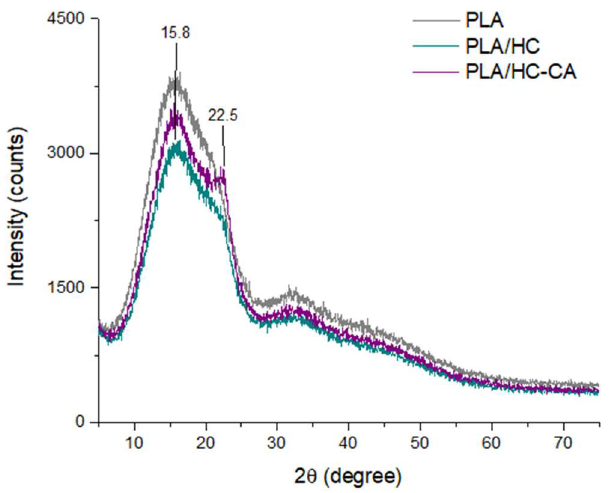
Figure 10. Representative XRD patterns of PLA-based biocomposite films (PLA + hemp cellulose; PLA + functionalized hemp cellulose), compared to neat PLA. Spectra were processed using OriginPro 2015